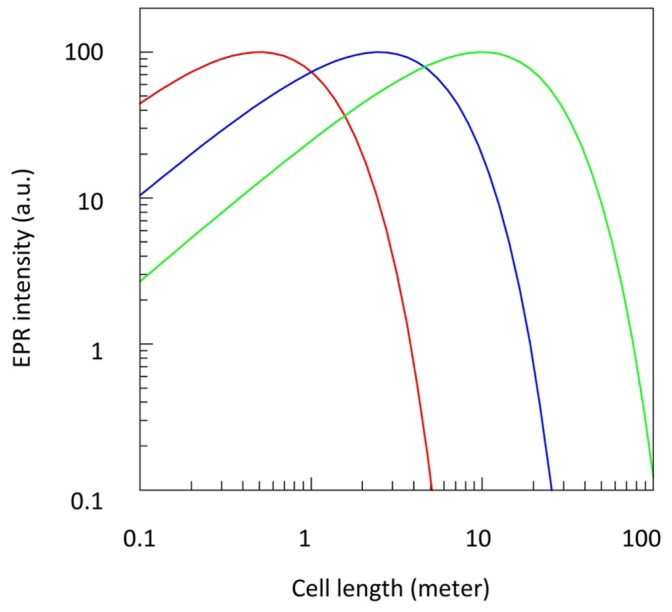
Transmission EPR signal from samples in lossy media as a function of cell length.These theoretical curves are based on eqn (37). Loss in dB/m is 40 (red), 8 (blue), or 2 (green). Maximal amplitudes are normalized to 100%.